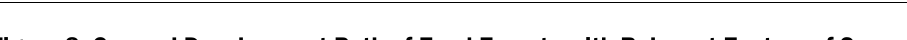
Figure 8. General Development Path of Food Forests with Relevant Factors of